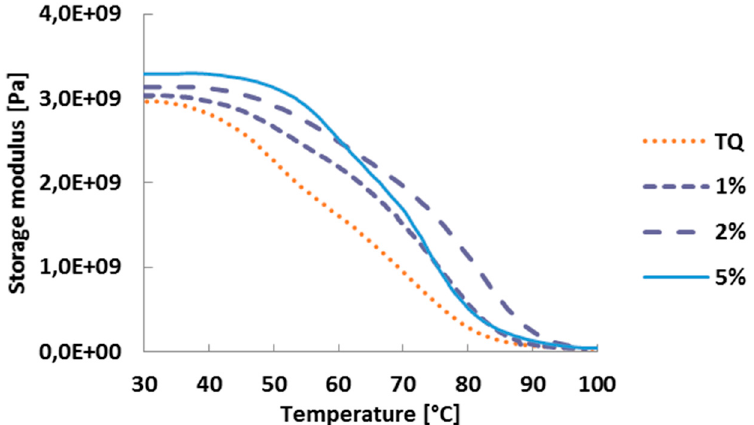
Figure 8. Storage moduli of the different specimens measured by DMA.